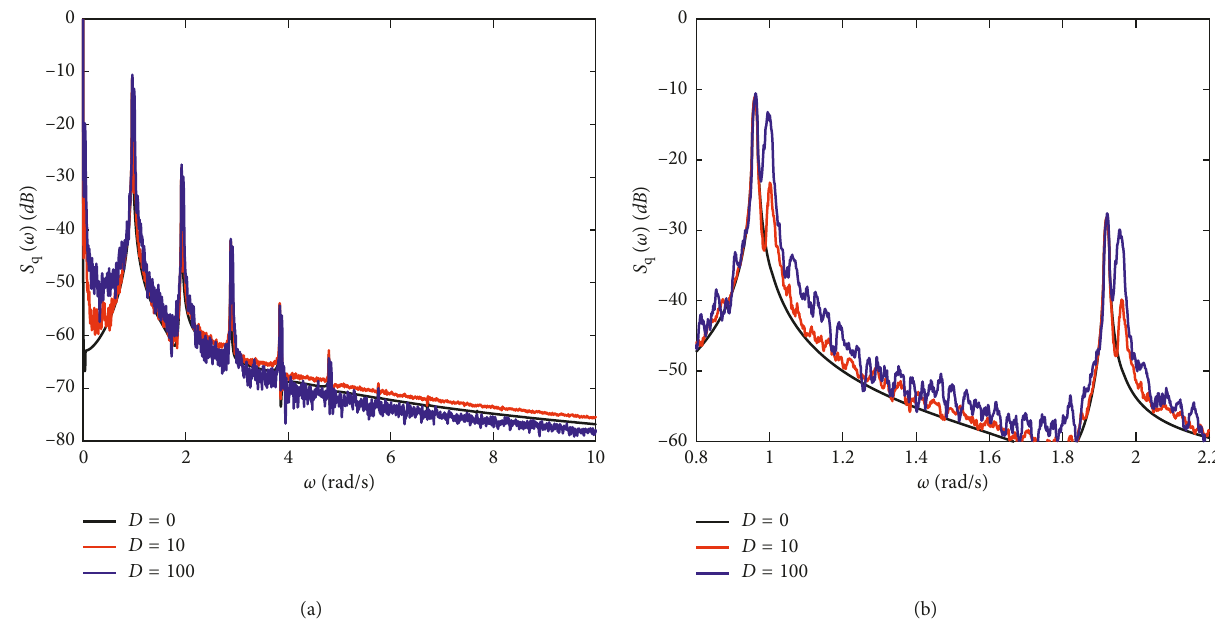
Figure 8: PSD curves with variable D when v �